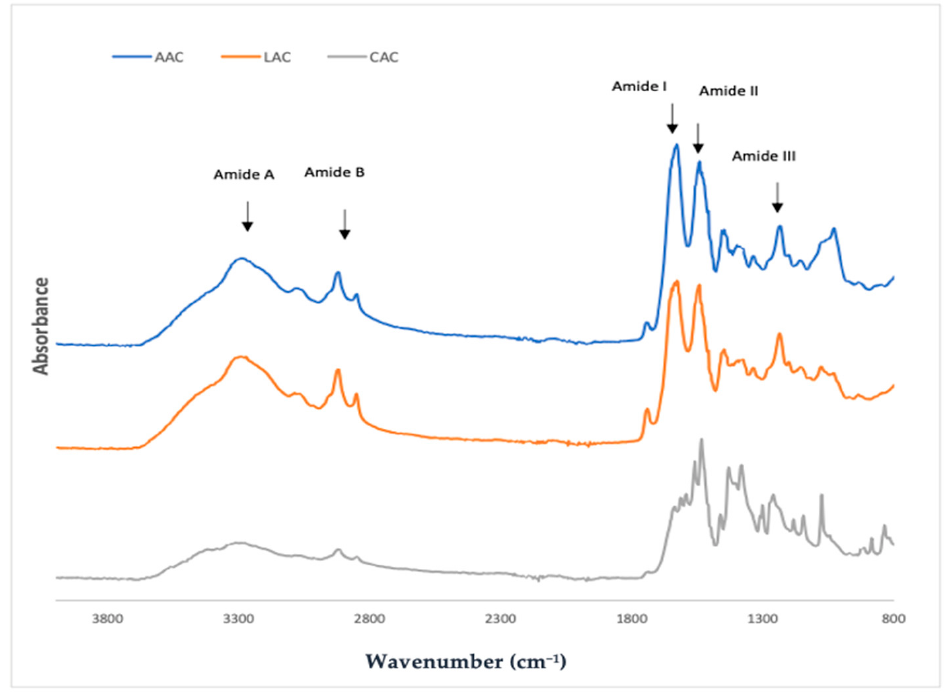
Figure 1. UV absorption of needlefish skin collagens extracted with different acids. AAC: acetic acid collagen; LAC: lactic acid collagen; CAC: citric acid collagen.